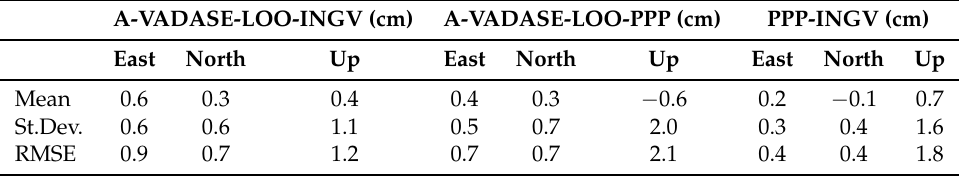
Table 10. Differences of coseismic displacements: 30 October 2016